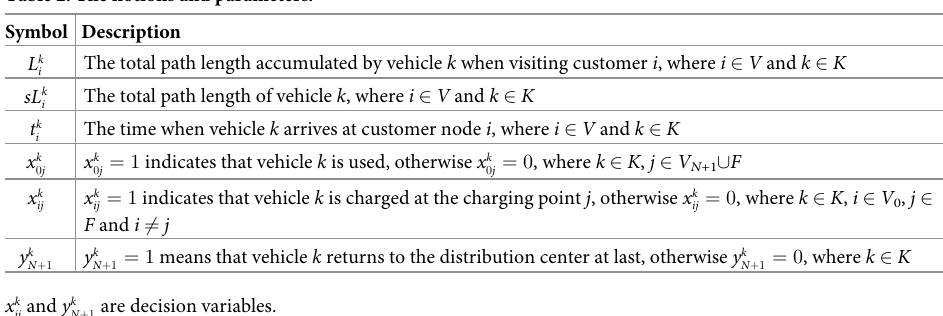
Table 2. The notions and parameters. Symbol Description The total path length accumulated by vehicle k when visiting customer i , where i 2 V and k 2 K L k i The total path length of vehicle k , where i 2 V and k 2 K sL k i The time when vehicle k arrives at customer node i , where i 2 V and k 2 t k i